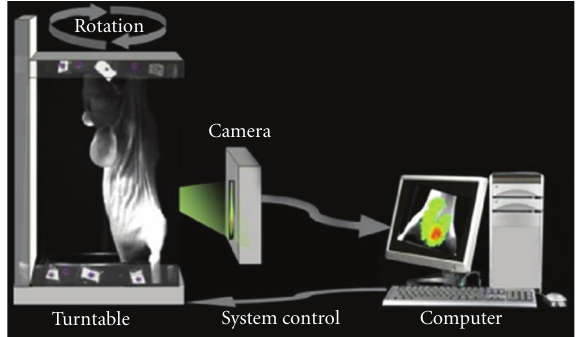
Figure 2: System block diagram of the in vivo imaging system, developed by ourselves. The region near the bladder belongs to the view of the CCD camera.